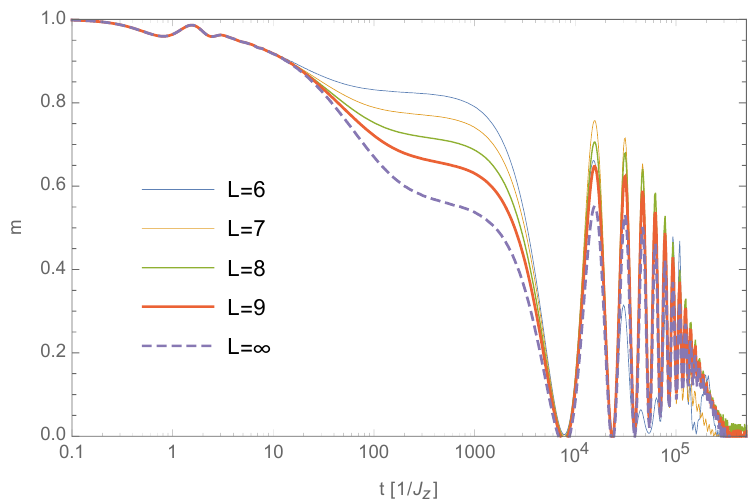
Figure 4: In case of large anisotropy the decay of magnetization is extremely slow, here shown for J to L = ∞ . Between t